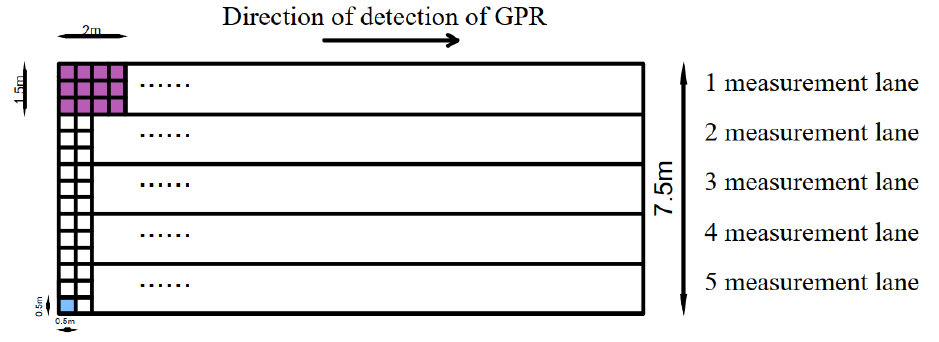
Figure 11. GPR detection distribution map.